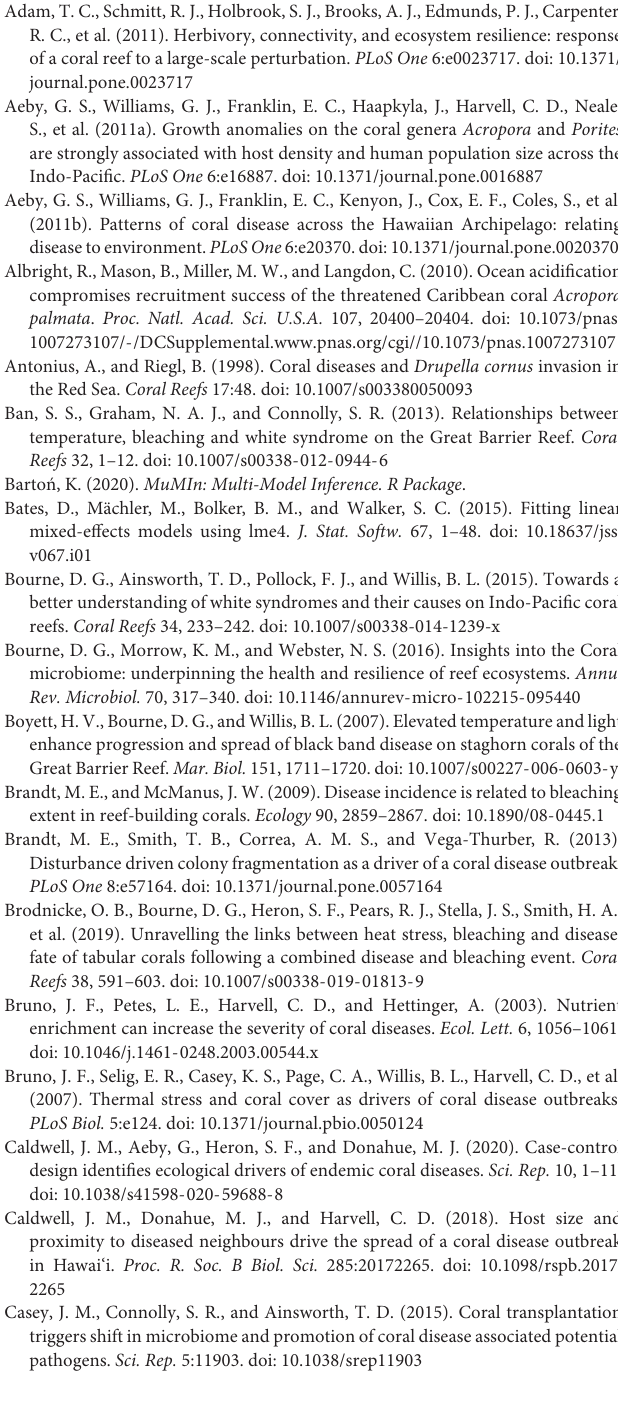
Supplementary Figure 9 | Predicted (black) and observed (blue) total WS cases per transect through time for both model training data (left, in-sample) and reserved model testing data (right, out-of-sample) based on a p(WS) = 0.25 probability decision rule. Supplementary Figure 10 | The influence of coral cover on colony-scale probability of White Syndrome varies by site (left) and by species (right). Left panel: